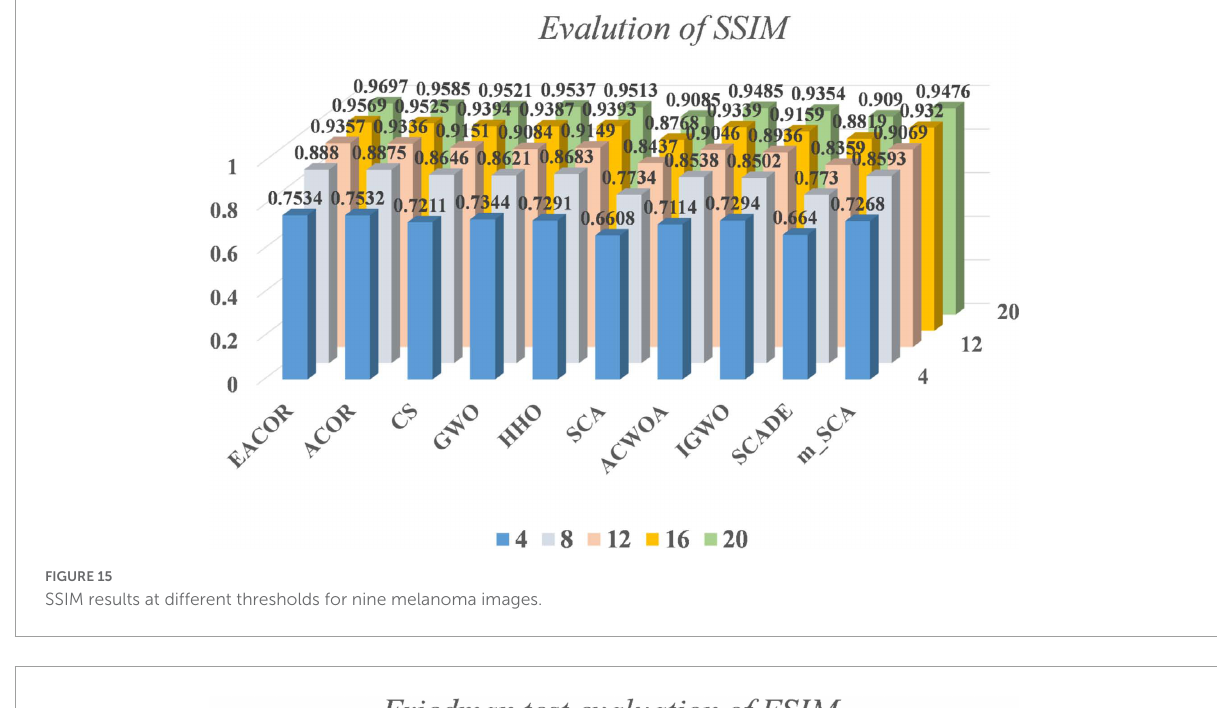
FIGURE15 SSIM results at different thresholds for nine melanoma images.